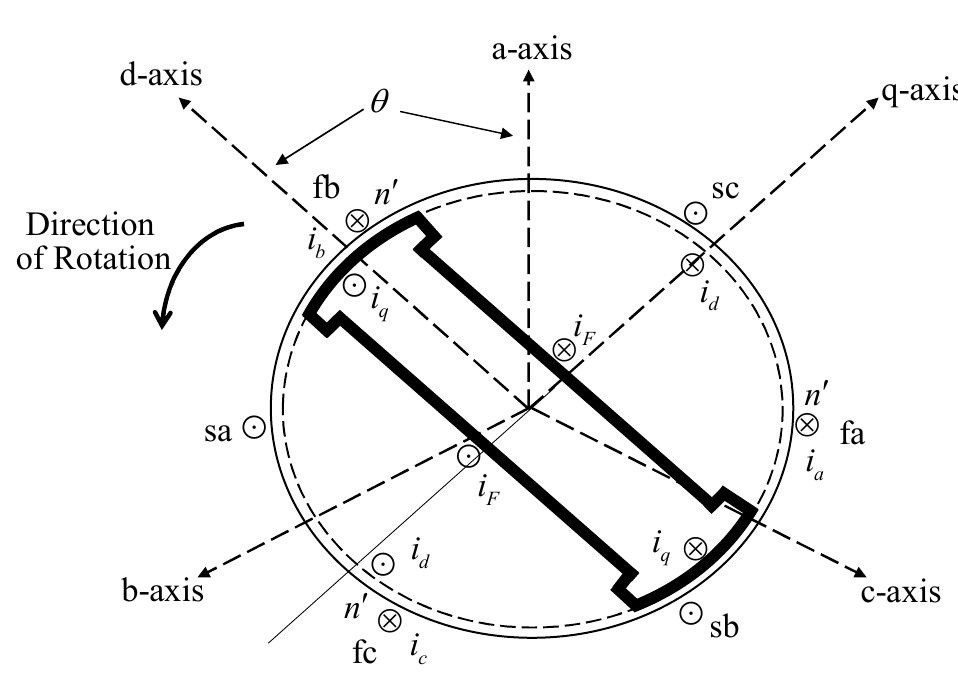
Figure 16. Schematic diagram of a three-phase synchronous machine. Fig. 14 . Schematic